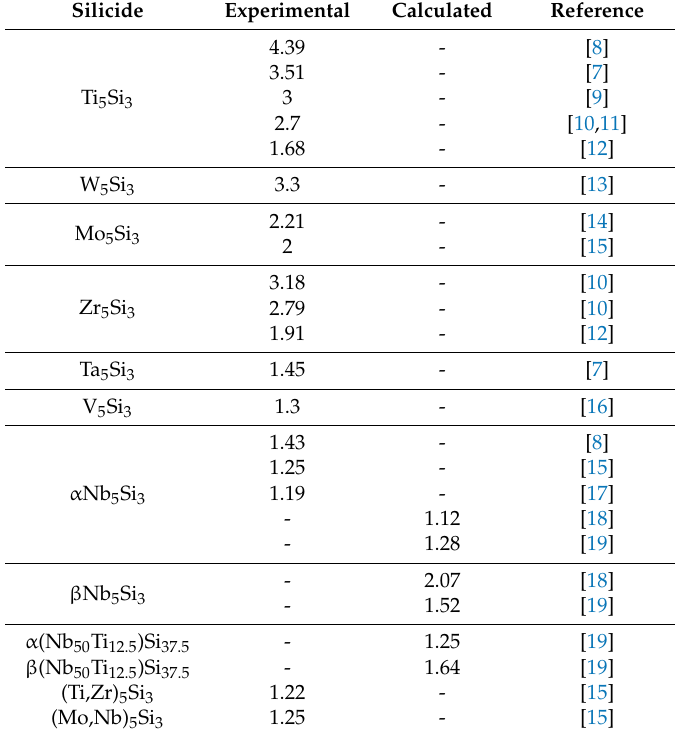
Table 1. Experimental and calculated data for the CTE anisotropy [(CTE) c /(CTE) a ] of binary and alloyed TM 5 Si 3